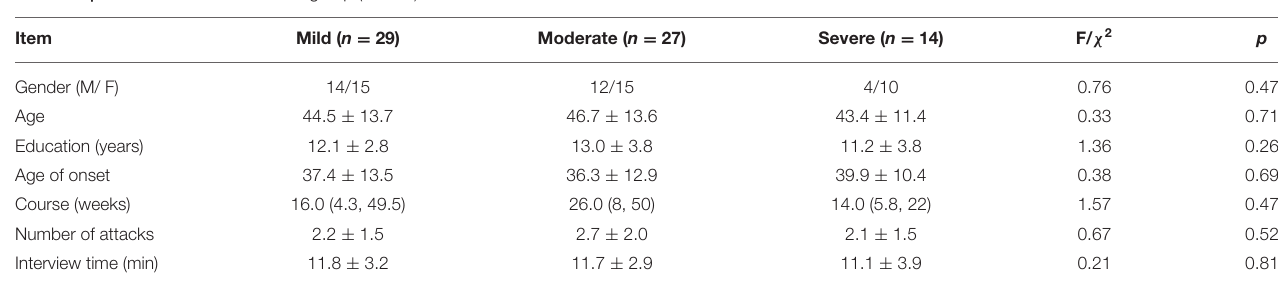
TABLE 1 | General information in each group ( n =